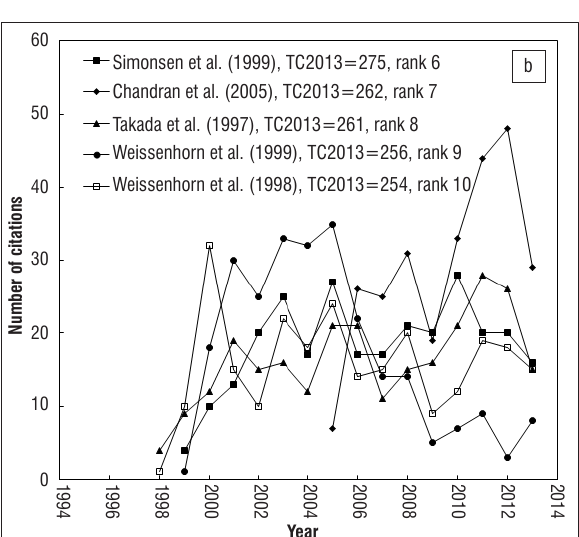
>280) and (b) the 2013 > 2013